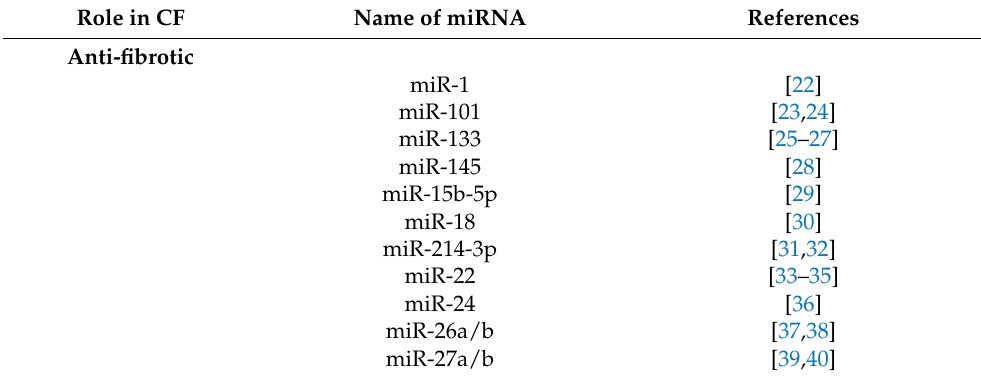
Table 1. MiRNAs associated with cardiac fibrosis.